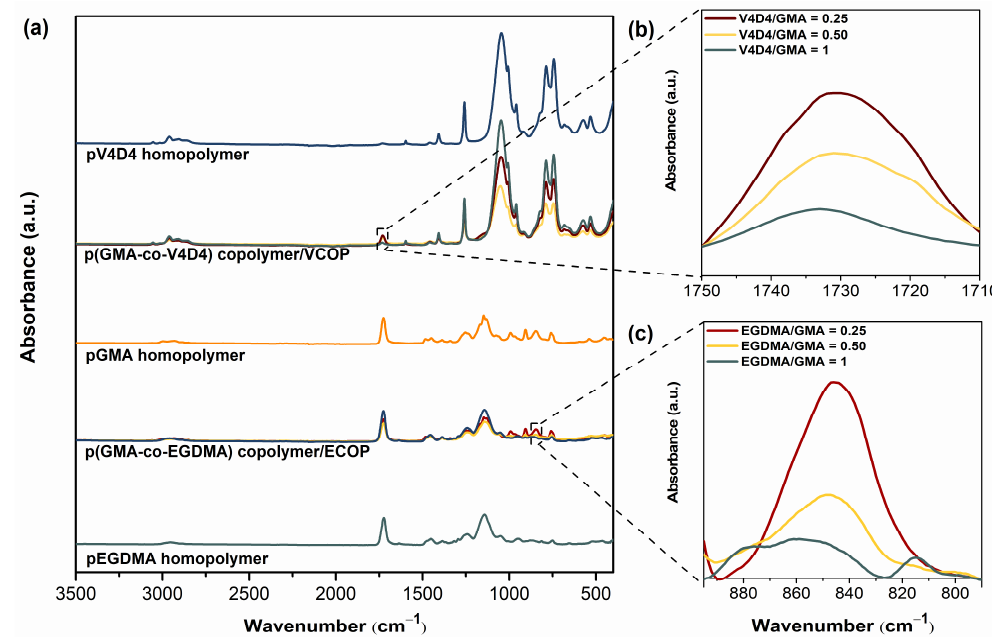
Figure 4. FTIR spectra of ( a ) GMA, EGDMA and V4D4 homopolymers and their copolymers, ( b ) poly(GMA-co-V4D4) copolymers, and ( c ) poly(GMA-co-EGDMA) copolymers.